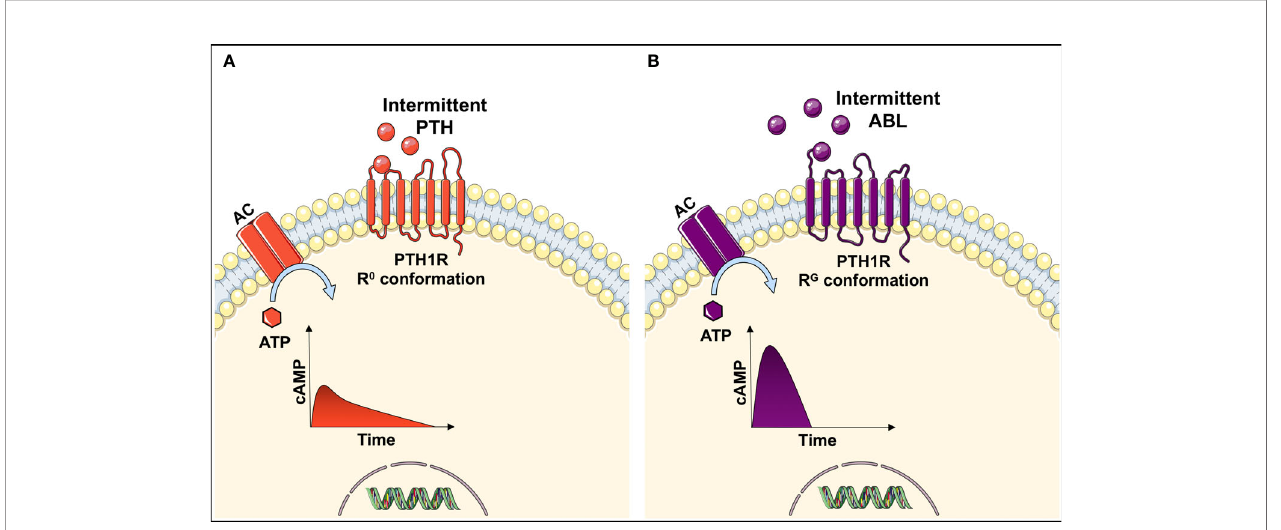
FIGURE 1 | Intracellular signaling response after parathyroid hormone (PTH) (A) or abaloparatide (ABL) (B) binds to the parathyroid hormone 1 receptor (PTH1R) on osteoblasts. When PTH binds to the R0 conformation of the receptor the adenyl cyclase (AC) converts adenosine triphosphate (ATP) to cyclic adenosine monophosphate (cAMP), thus resulting in a prolonged increase in cAMP. In contrast to abaloparatide, which is more selective in favor of binding the RG conformation of PTH1R and thereby inducing a more temporal signaling response by a short and rapid increase in cAMP (9, 19,